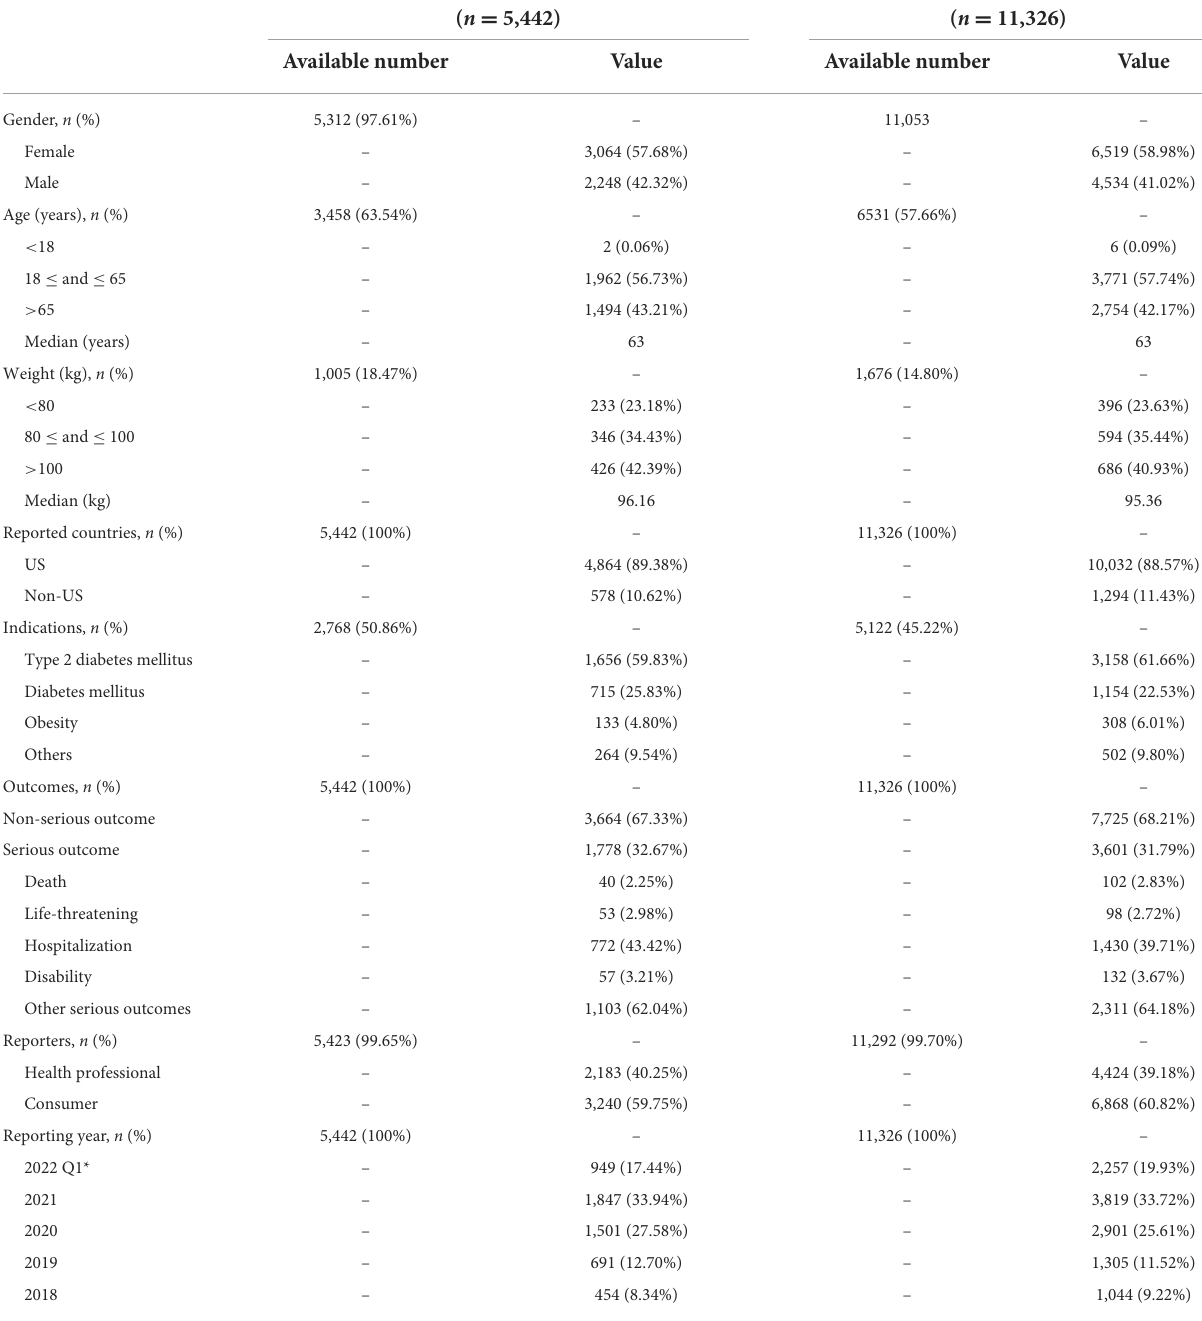
TABLE 1 Clinical characteristics of patients with semaglutide-associated gastrointestinal adverse